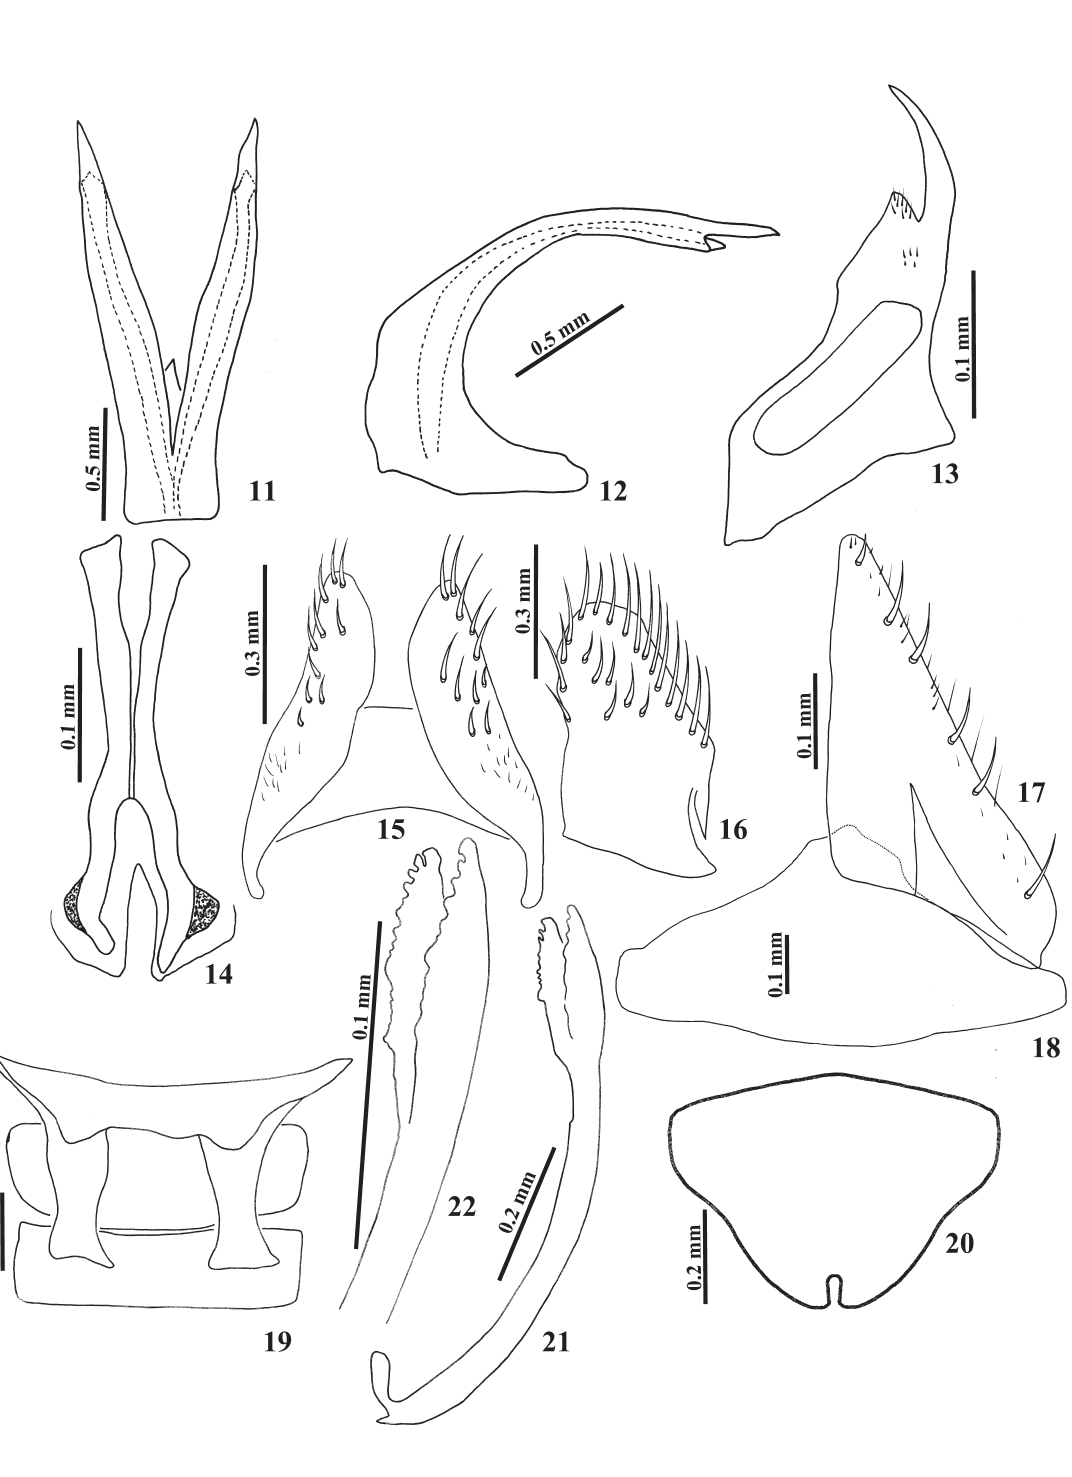
Figs 11–22 . Masiripius lugubris (Distant, 1918). 11 . Aedeagus dorsal view. 12 . Aedeagus lateral